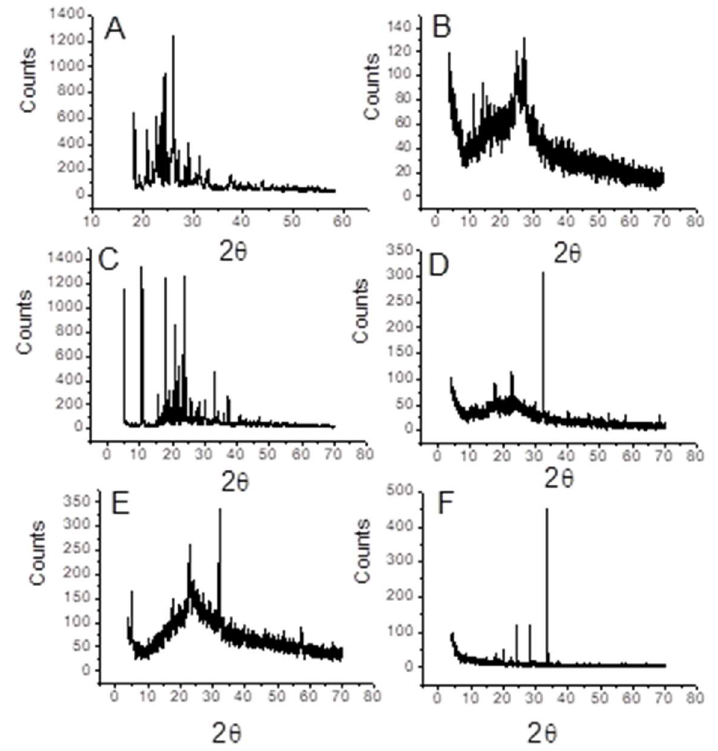
Figure 7. X-ray diffraction scans of the TZD with the six π-acceptors; ( A ): PA, ( B ): DDQ, ( C ): TCNQ, ( D ): DCQ, ( E ): DBQ, and ( F ): NBS.